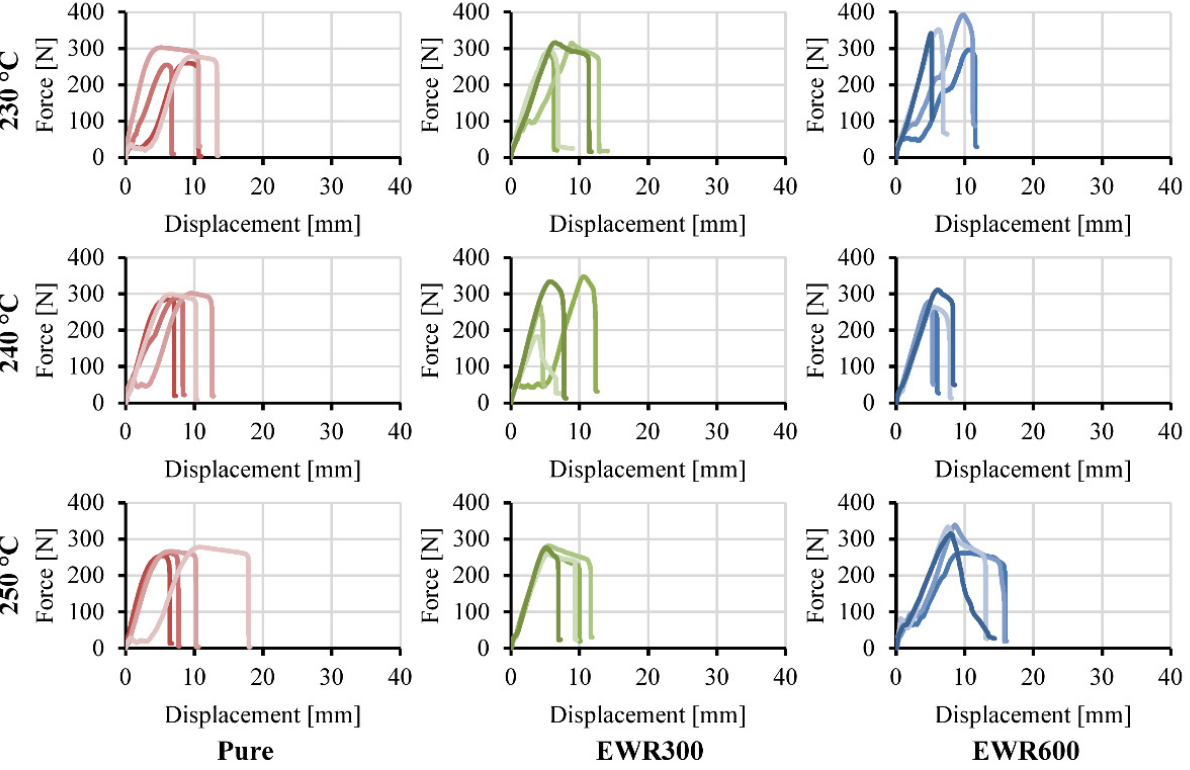
Figure 11. Force-displacement curves of the tensile foamed samples prepared at different injection temperatures. The different color shows different samples.